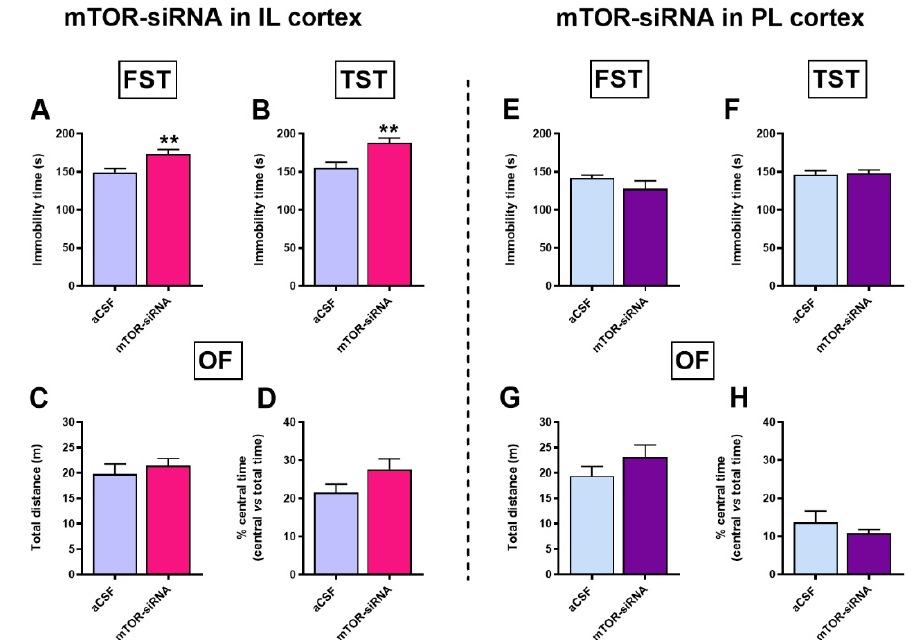
Figure 1. Acute mTOR knockdown in the infralimbic, but not in the prelimbic cortex, induces a depressive-, but not anxious-like behavior. Depressive-like responses were examined using ( A ) forced swimming test and ( B ) tail suspension test, respectively, 24 h and 48 h after unilateral mTOR-siRNA infusion in the IL cortex. No changes were observed in ( C ) locomotion or ( D ) anxiety-related behavior in intra-IL mTOR knockdown mice evaluated in the open-field test 24 h after siRNA infusion. ( E – H ) No behavioral changes were observed when mTOR was knocked down in the PrL cortex. Results are presented as mean ± S.E.M. Unpaired Student’s t -test, ** p < 0.01. n = 7–9 animals per group. aCSF: artificial cerebrospinal fluid; IL: infralimbic; PrL: prelimbic; FST: forced swimming test; TST: tail suspension test; OF: open-field test; siRNA: small interfering